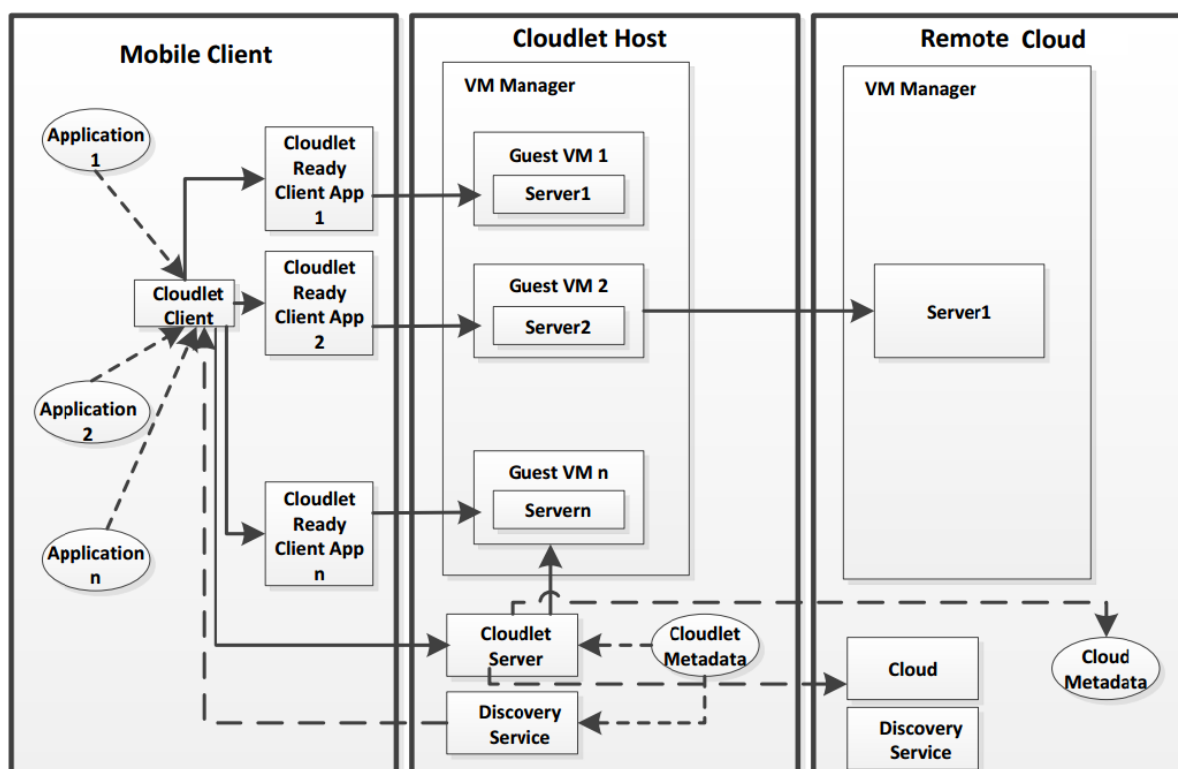
Figure 2. Proposed Multi-Latency Aware Offloading System Based on MLAWAS